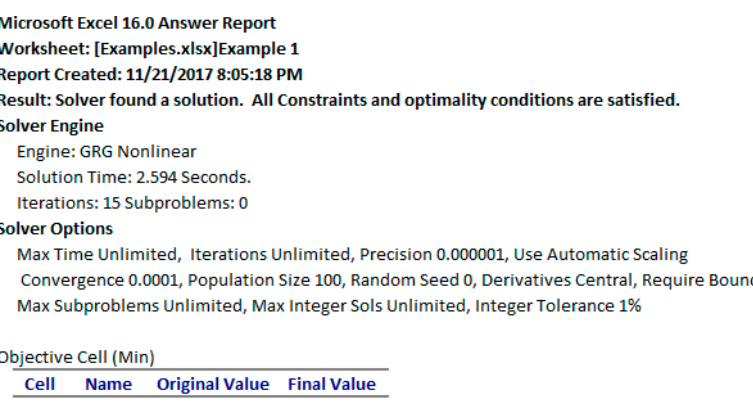
Figure 5. Excel’s Solver dialog configured for optimal control problem (6)–(10).